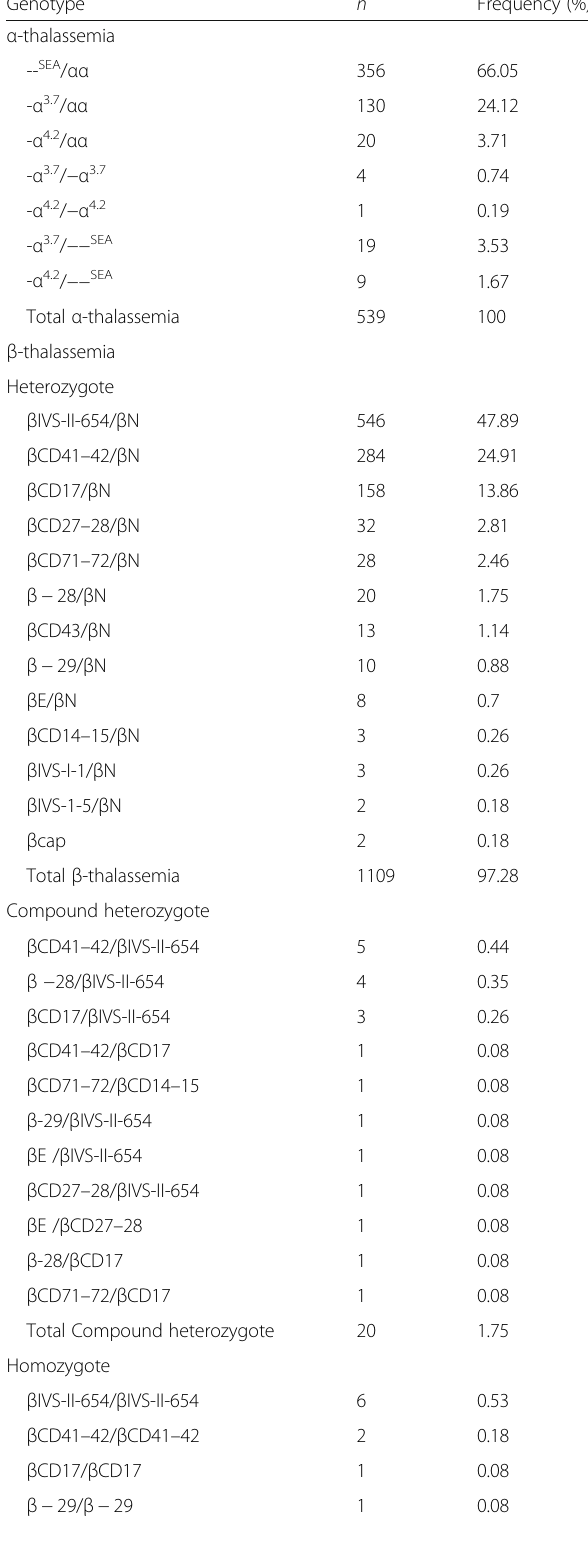
Table 1 Genotype, number of subjects and frequency of thalassemia deletions